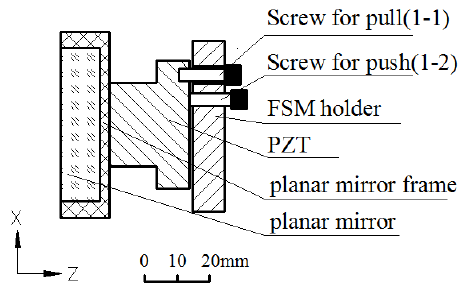
Figure 10. FSM structure.